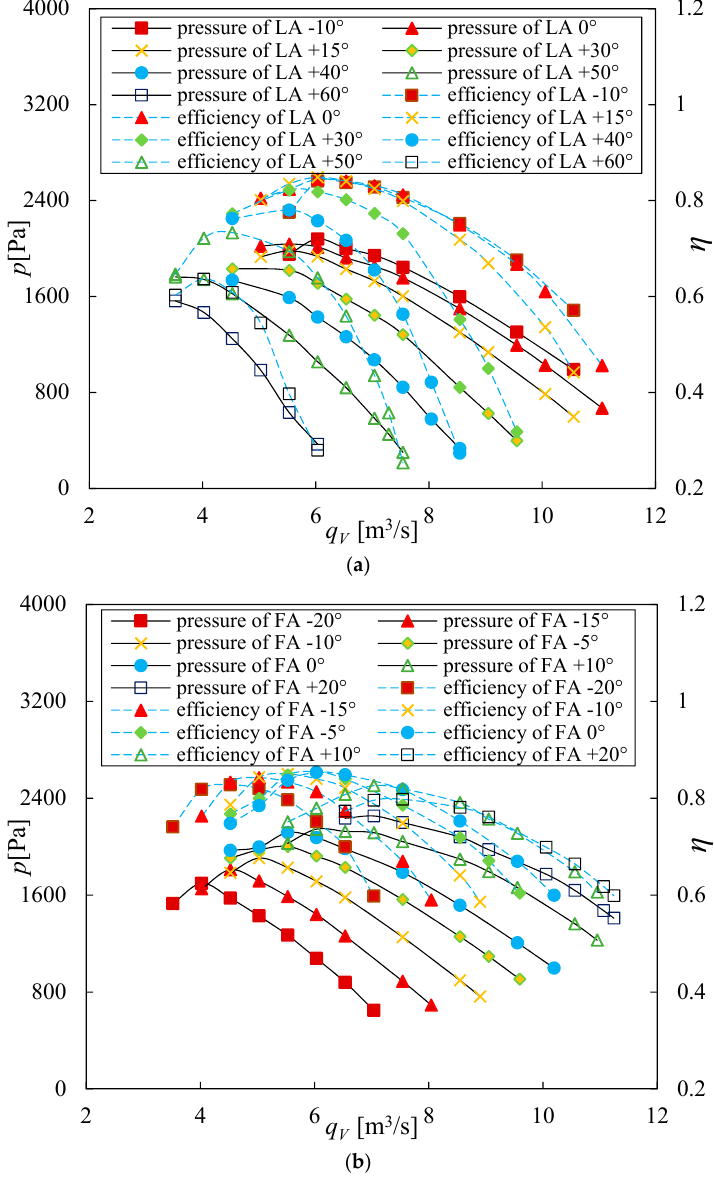
Figure 7. FE results about total pressure and efficiency based on ( a ) LA; ( b ) FA.